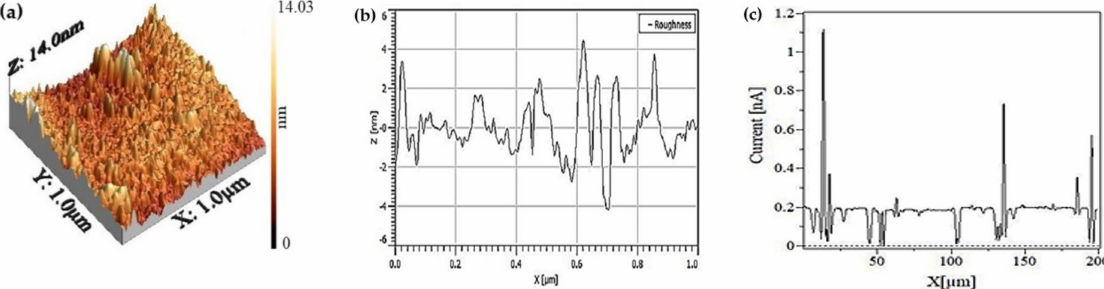
Figure 3. Atomic force microscopy images of CSCM ( a ) 3D topography, ( b ) roughness profile, and ( c ) current